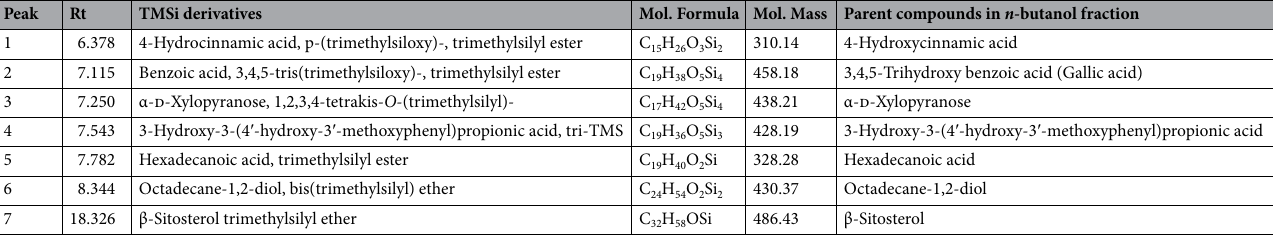
Table 7. GC–MS analysis of the n -butanol fraction of S. officinarum after TMSi